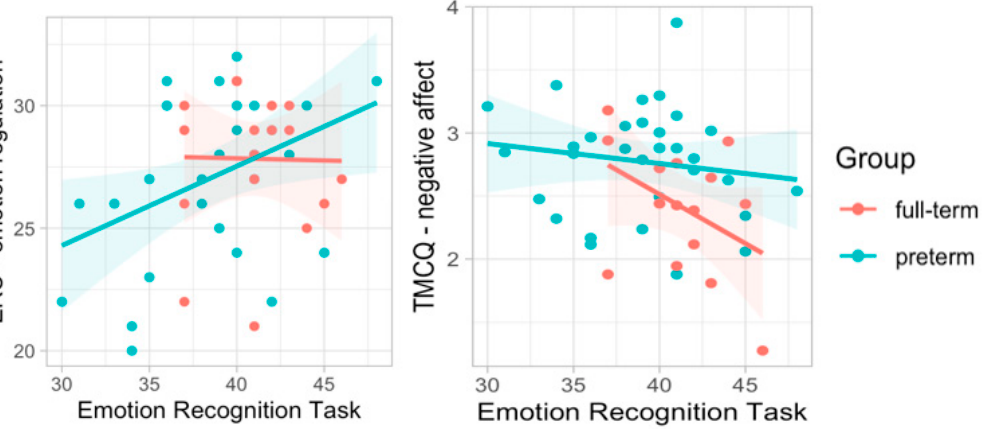
Figure 5. Correlations between ERT and the subscales of Peer Problems and Prosocial Behavior of the SDQ.